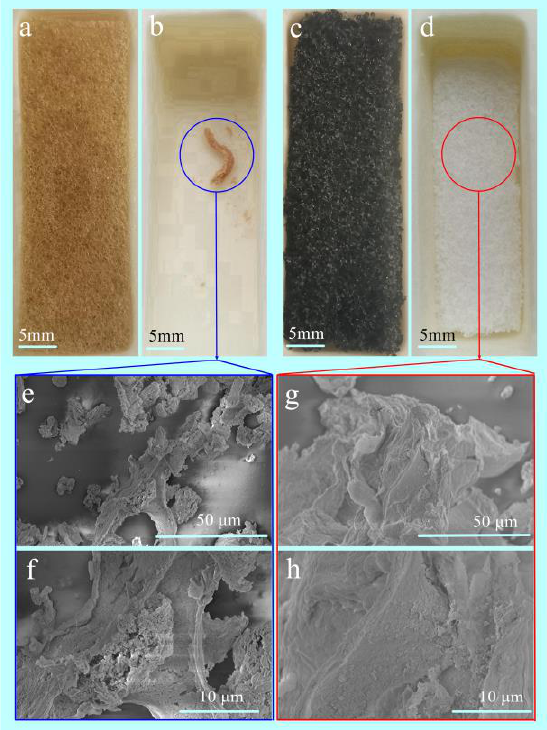
Figure 4. The image of PUS ( a , b , e , f ) before and ( c , d , g , h ) after modification at different temperatures ( a , c ) 20 ◦ C; ( b , d , e , f , g , h ) 750 ◦ C.